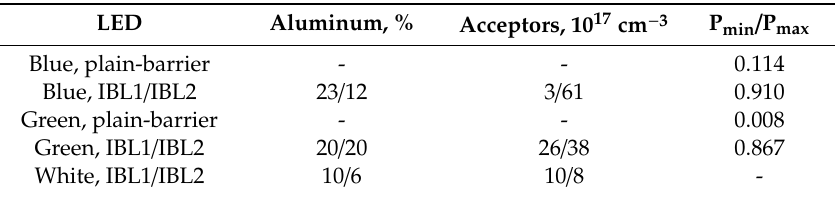
Figure 5. Injection dependence of white-color LED chromaticity characteristics. ( a ) chromaticity diagram of LED emission. Large cross markers indicate white light (black cross) and RGB main colors; small colored cross markers show nominal QW emission locus points. ( b ) Injection dependence of the chromaticity coordinates of representative points on the LED chromaticity locus line. Table 2. IBL characteristics in simulated